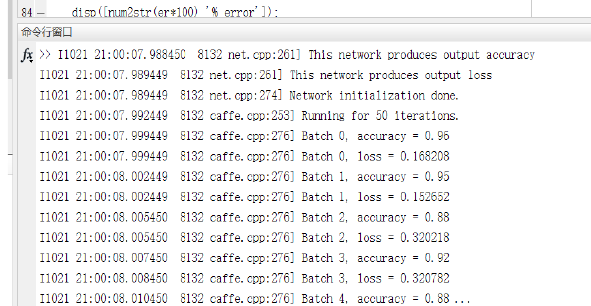
Figure9 . Training model